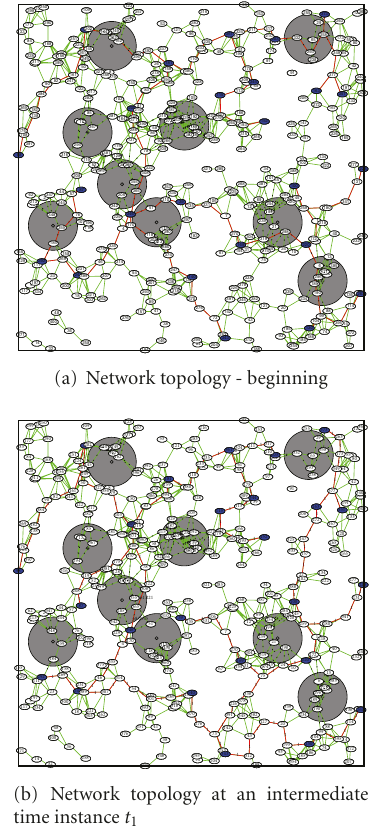
Algorithm 3: Inactive node procedure for its activation.